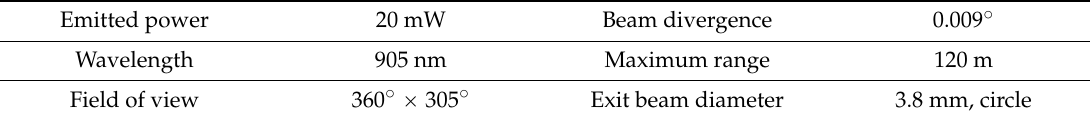
Figure 3. Instruments and equipment utilized in the experiments. Four Lambertian targets with a size of 10 cm× 10 cm and reflectance of 20%, 40%, 60%, and 80% were mounted on a board that can rotate horizontally through a goniometer. The instrument used was Faro Focus 3D 120. Table 1. Main system parameters of Faro Focus 3D 120.